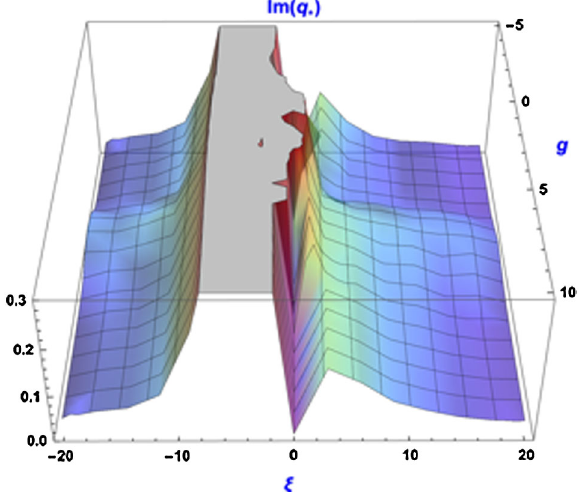
FIG. 16. Growth rate versus intensity and chromaticity; the damper is off.